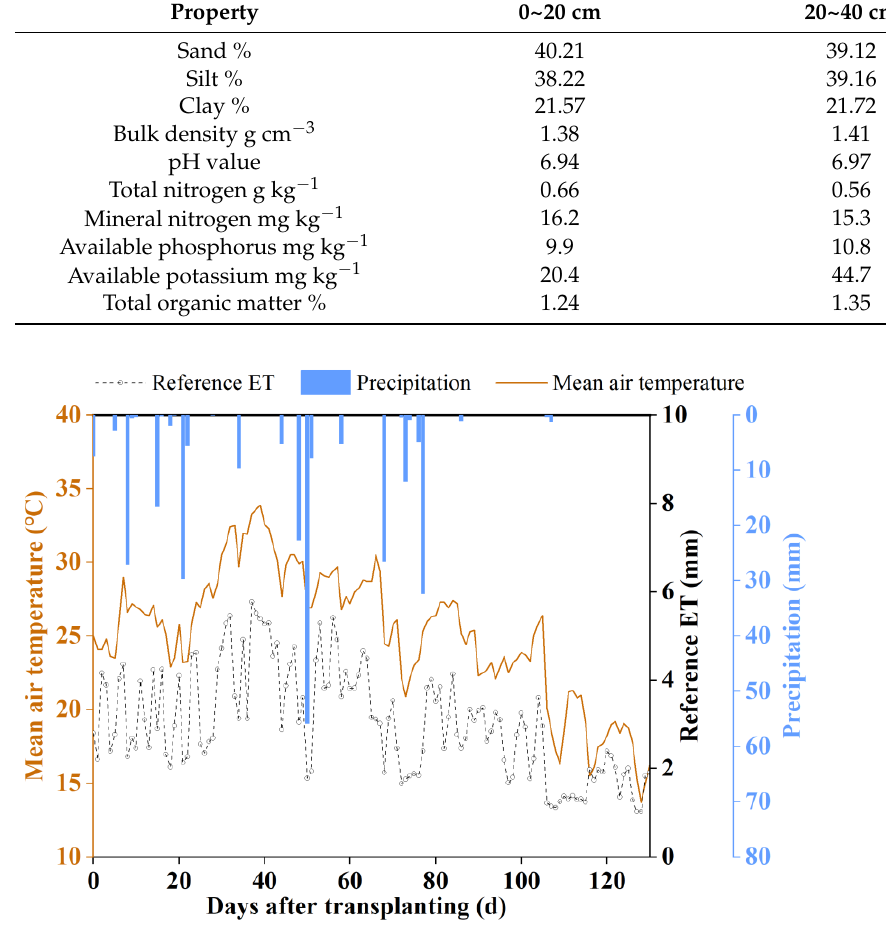
Figure 2. Variation of daily average air temperature, reference evapotranspiration and precipitation during the experiment in Jiangning, China. The reference ET refers to the reference crop evapotran- spiration, which was calculated from the meteorological data of the experimental site.